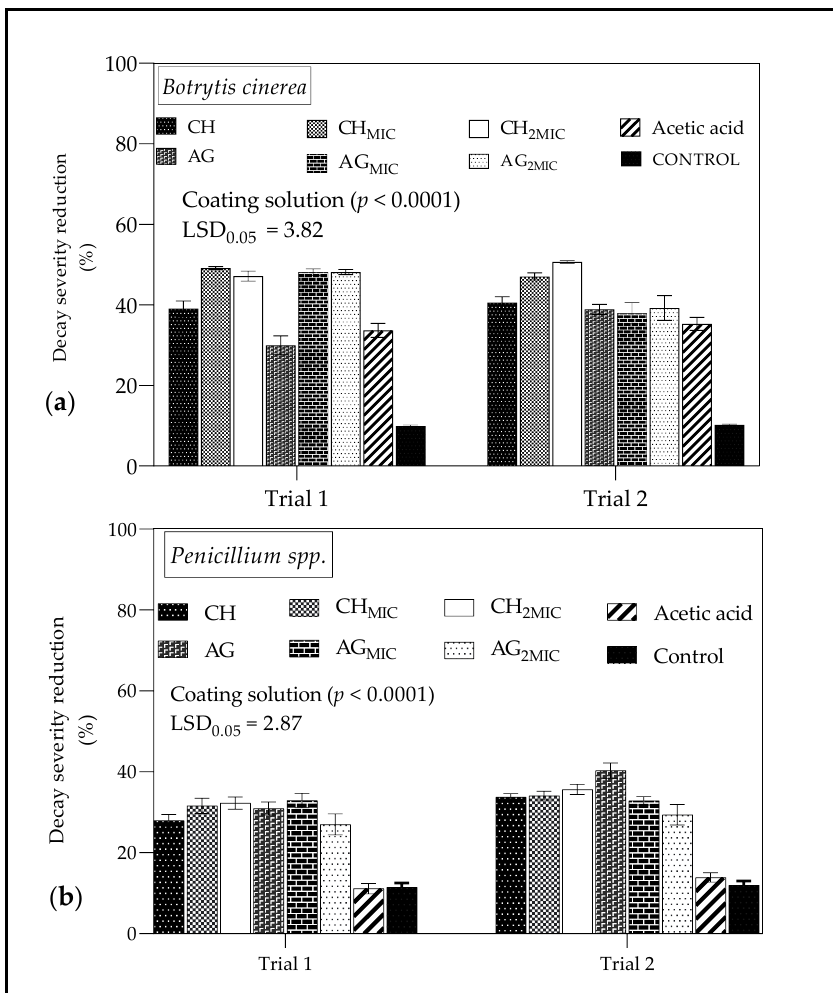
Figure 6 . Decay severity reduction with respect to control (%) of coated ‘Wonderful’ pomegranate inoculated with ( a ) Botrytis cinerea and ( b ) Penicillium spp. and incubated for 10 day at 22 ◦ C and 25 ◦ C, respectively. MIC—minimum inhibitory concentration; 2MIC—double the minimum inhibitory concentration. B. cinerea (MIC = 15 µ L/mL; 2MIC = 30 µ L/mL) and Penicillium spp. (MIC = 30 µ L/mL; 2MIC = 60 µ L/mL); CH—chitosan; CH MIC —chitosan formulated with lemongrass oil at minimum inhibitory concentration (15 or 30 µ L/mL); CH 2MIC —chitosan formulated with lemongrass oil at double the minimum inhibitory concentration (30 or 60 µ L/mL); AG—sodium alginate; AG MIC —sodium alginate formulated with lemongrass oil at minimum inhibitory concentration (15 or 30 µ L/mL); AG 2MIC —sodium alginate formulated with lemongrass oil at double the minimum inhibitory concentration (30 or 60 µ L/mL). Vertical bars represent the standard error (SE) of mean values of three replicates (5 fruit = replicate). LSD 0.05 represent least significant difference ( p <